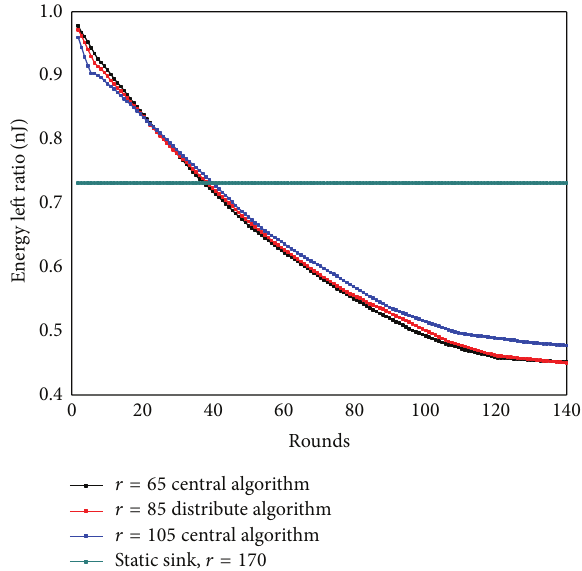
Figure 35: Maximum energy comparisons between centralized algorithm and distributed algorithm.